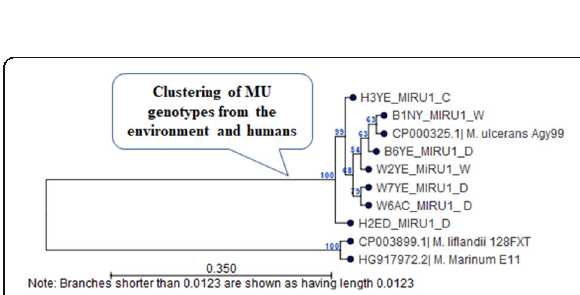
Fig. 3 Comparison of MU VNTR profiles between the environment and humans. The relatedness between the genotypes was inferred using the UPGMA method in MEGA 7. Bootstrapping values for 1000 replicates are shown in percentage next to the branches. MIRU1 reference orthologs for M . marinum ( the ancestor of MU ), M . liflandii (another MPM), and M . ulcerans Agy99 (MU reference strain) were retrieved from GenBank with accession numbers given in the tree. MU: M . ulcerans ; Sample test IDs and MU genotypes C, D, W are shown for environmental samples (B1NY, B6YE, W2YE, W7YE, W6AC) and BU lesions (H2ED, H3YE). The figure reveals clustering of MU genotypes from the environment and